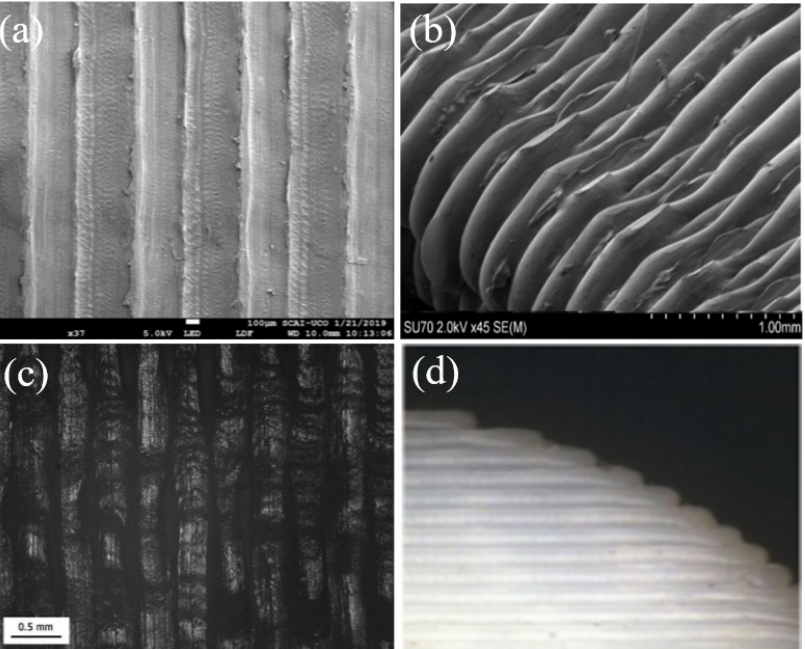
Figure 15. ( a ) Cross ‐ section of CF reinforced PLA filament. ( b ) Magnified cross ‐ section of CF reinforced PLA filament. ( c ) Cryo ‐ fractured surface of 15% CF reinforced PP composite. ( d ) Cryo ‐ fractured surface of 20% CF reinforced PP composite. ( a ),( b ): [69], ( c ),( d ): [153].